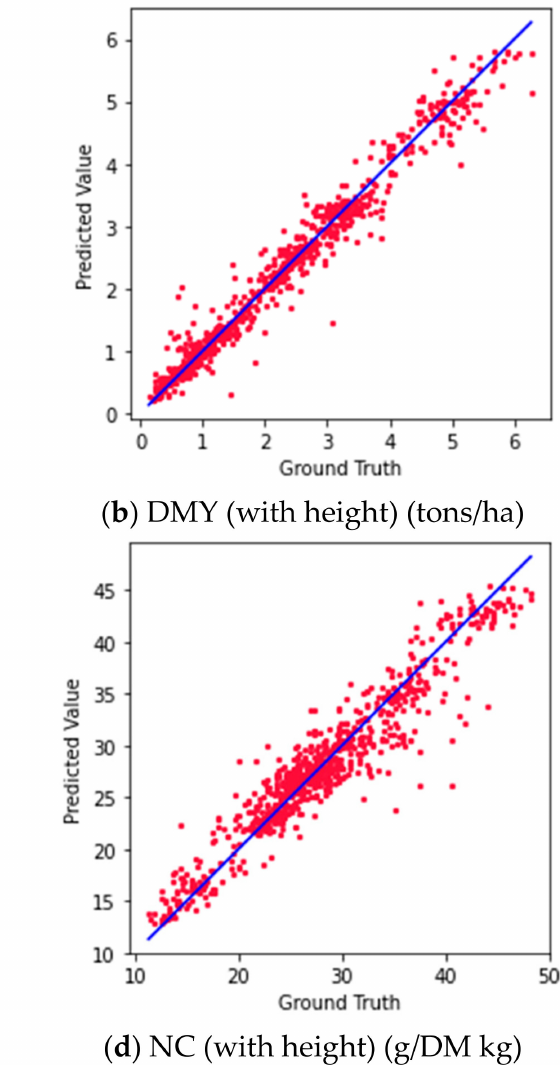
Figure 6. Plots of ground truth and predicted values. X-axis represents the ground truth data of the test dataset. In contrast, the Y-axis represents the predicted values by random forest regressor model using input features of the test data set. ( a ) DMY using hyperspectral data as input; ( b ) DMY using hyperspectral data and height data; ( c ) NC using hyperspectral data as input; ( d ) NC using hyperspectral data and height